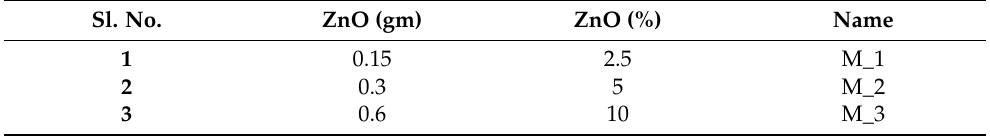
Table 1. Naming of the PVA nanocomposite membranes with varying ZnO concentration. Sl. No. ZnO (gm) ZnO (%)